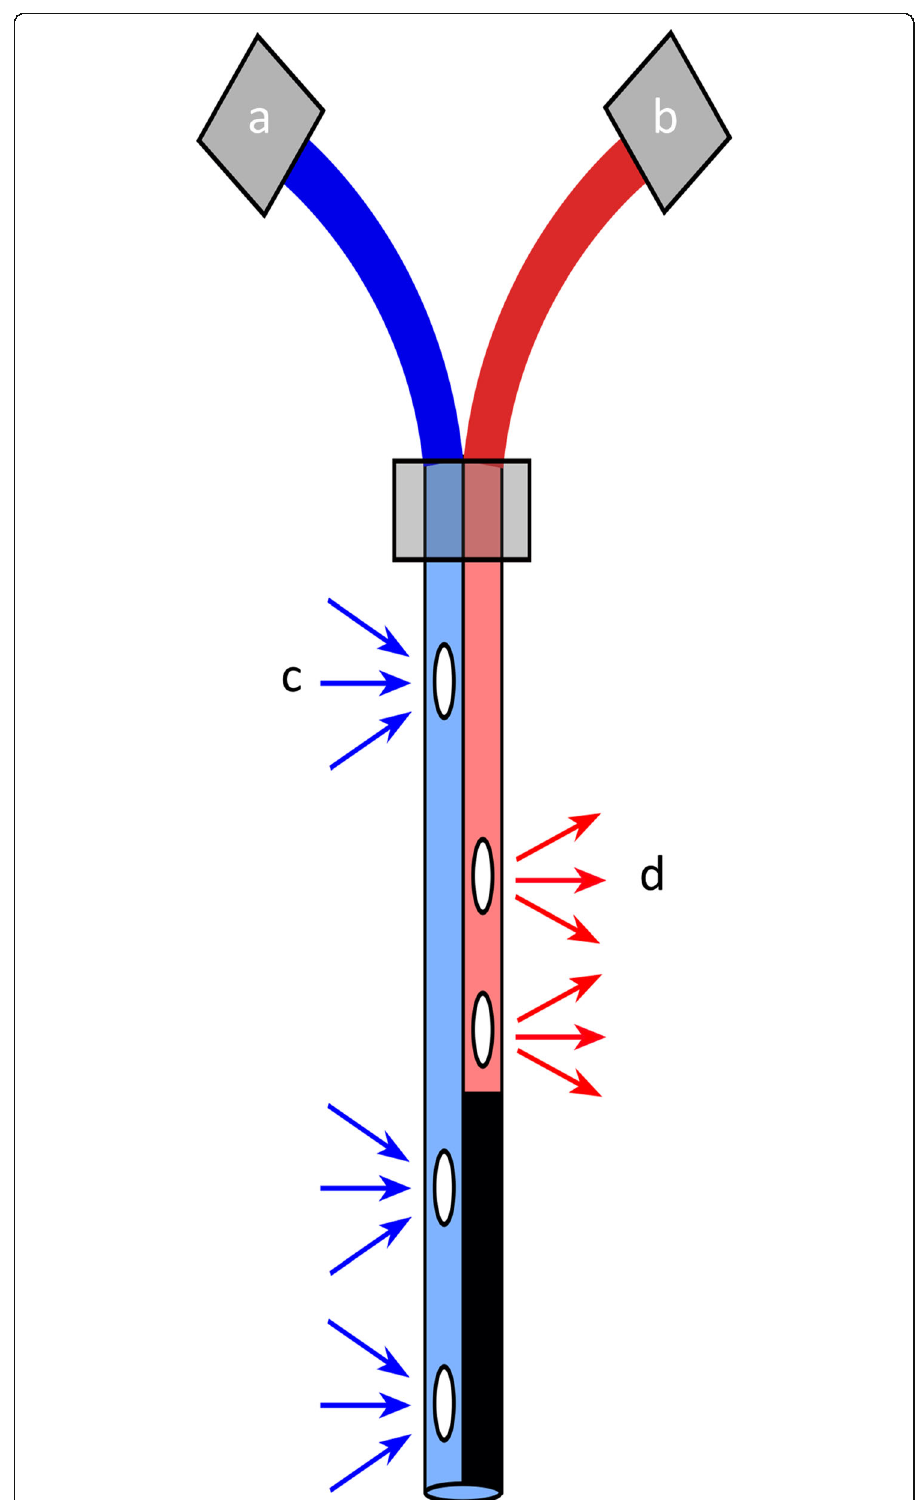
Fig. 2 Schematic depiction of the double lumen silicone cannula. Two lines were constructed into a single cannula. One line extracts blood ( a ) from the upper and lower vena cava before passing it through the oxygenator and giving the blood back in the right atrium ( b ). Blue ( c ) and red arrows ( d ) show the fenestrations in the